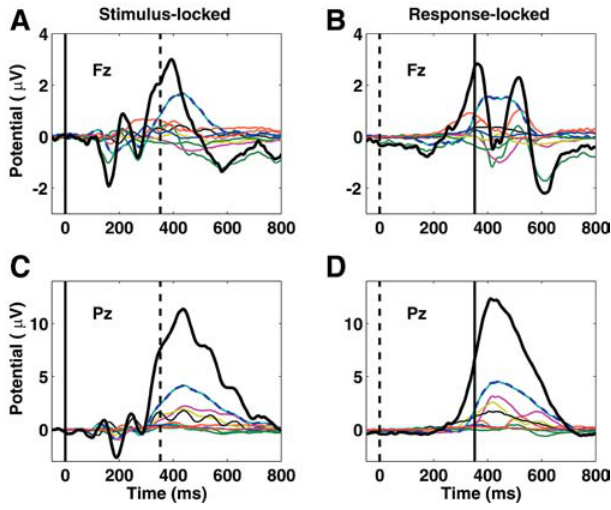
Figure 11. Cluster Projections to the Scalp ERP Component cluster contributions (in microvolts, thin traces) to the grand mean stimulus-locked (left) and motor-response-locked (right) target ERPs at scalp sites Fz (top) and Pz (bottom), plus their summed contributions (thick traces). Although the P3b cluster makes the largest contribution to the evoked responses at both scalp sites, its contribution does not outweigh the summed contributions of the other clusters. DOI: 10.1371/journal.pbio.0020176.g011